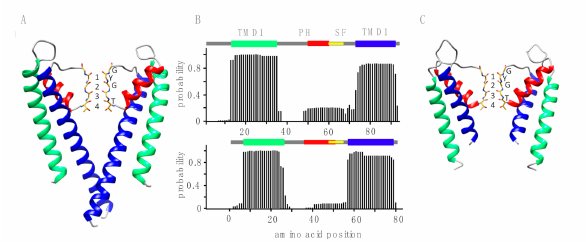
Figure 3. Structural elements of K + channels. ( A ) Two of the four monomers of the crystal structure of KcsA channel (PDB ID: 1K4C) with outer (TMD1, green) and inner (TMD2, blue) transmembrane domains, pore helix (PH, red), and consensus sequence of the selectivity filter (SF, yellow). Atoms of the main chain of SF are shown. Atoms of the side chain of T75 are shown as it contributes to the K + permeation pathway. Residues of the TXGYG consensus sequence are labeled, and the four K + binding sites are numbered. ( B ) Structural predictions for the sequences of functional Kcv (K + channel of chloroviruses) channel (Kcv PBCV1 , top) and putative TetV-1 channel (bottom). The algorithm TMHMM predicts transmembrane domains with a high probability in both sequences (green and blue bars). From their location, they are equivalent to TMD1 and TMD2 of KcsA. The JPred algorithm predicts an α -helix (red) upstream of the selectivity filter in both proteins. This is equivalent to the pore helix of KcsA. The colors in B correspond to the colored structural elements in A. ( C ) Two of the four monomers of the model structure of the TetV-1 protein (based on the KcsA structure, PDB ID: 1K4C (https: // www.rcsb.org / structure / 1K4C)) with outer (TMD1, green) and inner (TMD2, blue) transmembrane domains, pore helix (PH, red), and consensus sequence of the selectivity filter (SF, yellow). Atoms of the main chain of SF are shown. Atoms of the side chain of T51 are shown as it contributes to the K + permeation pathway. Residues of the TXGYG consensus sequence are labeled, and the four K + binding sites are